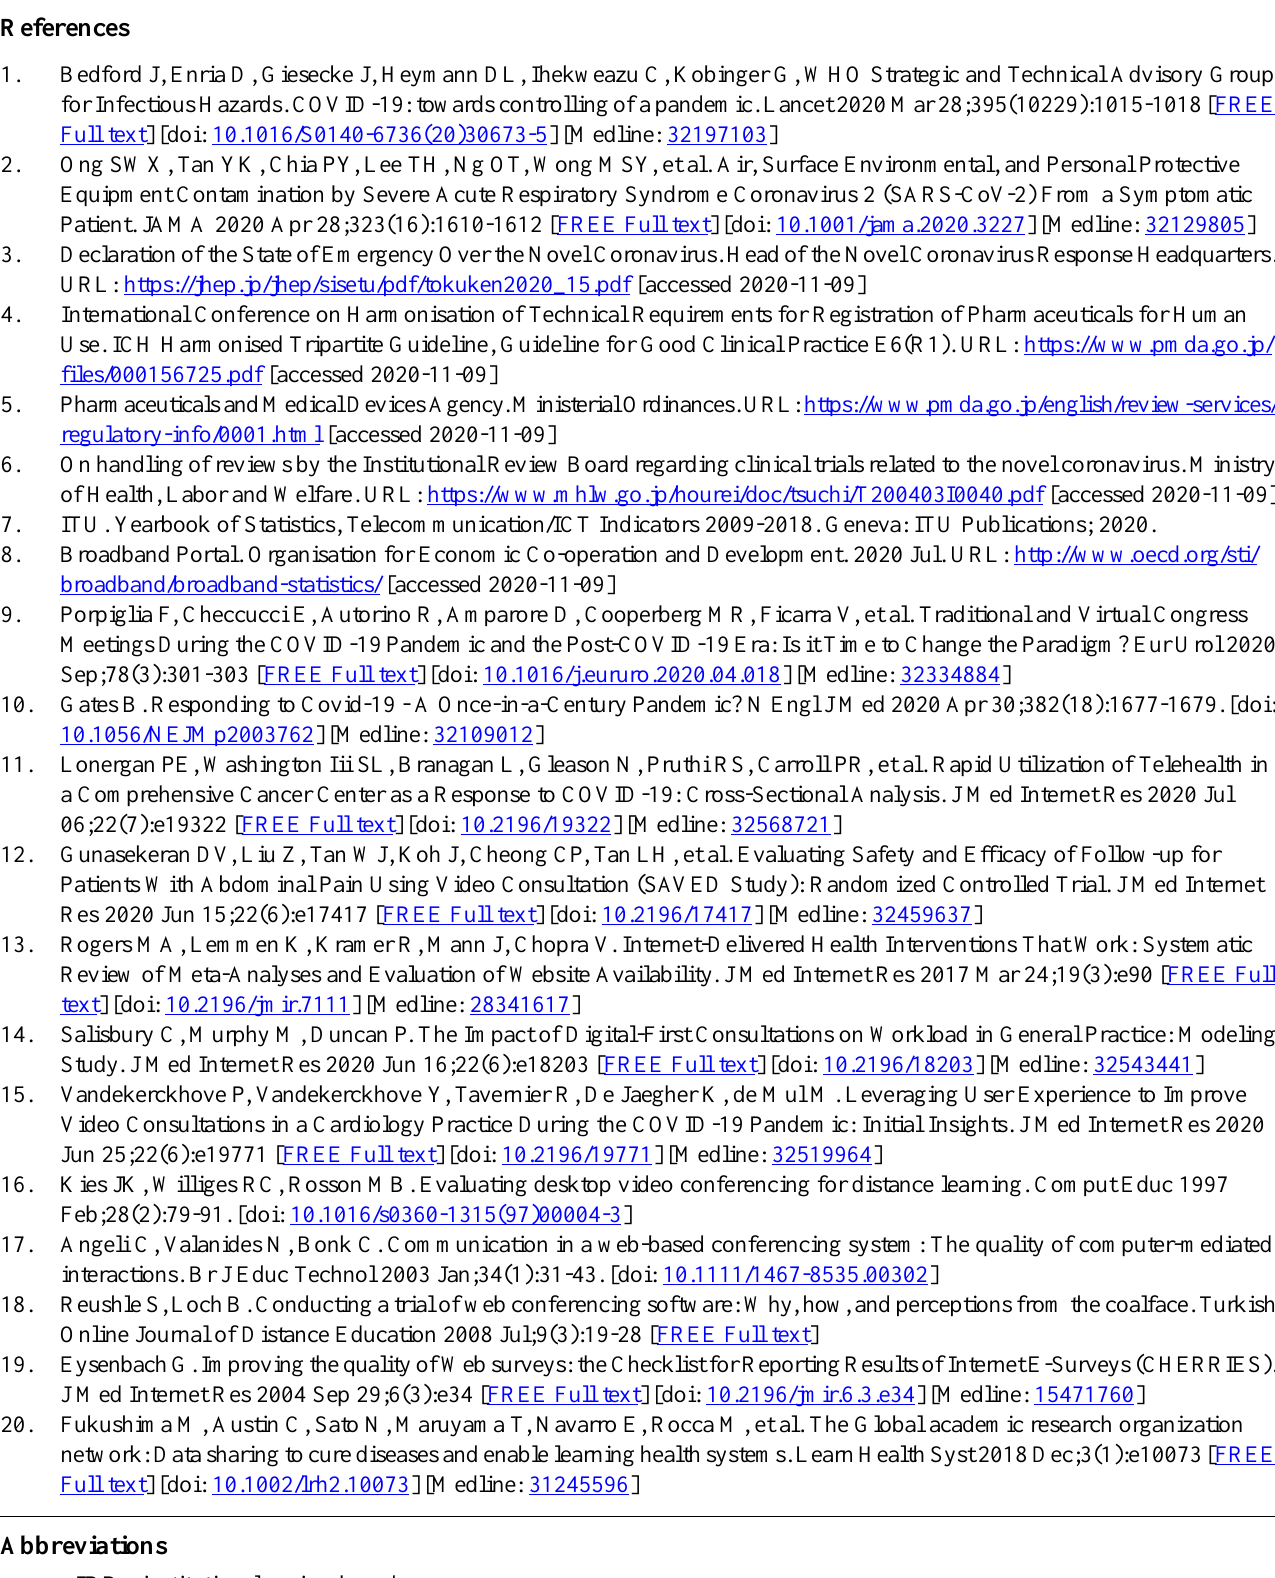
Table S1. The questions in the